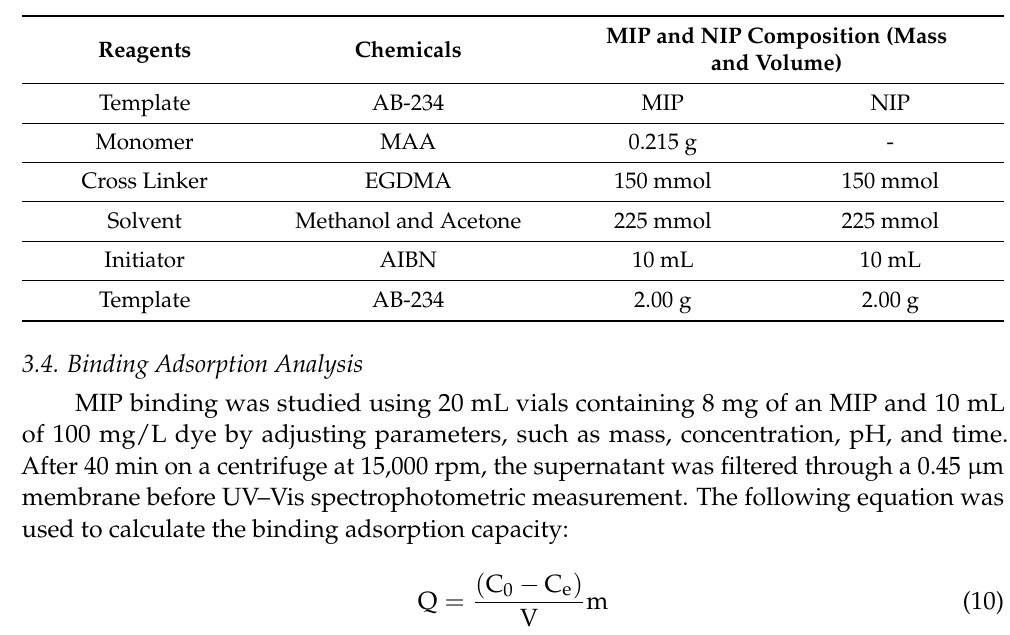
Table 9. Polymerization mixture of MIP